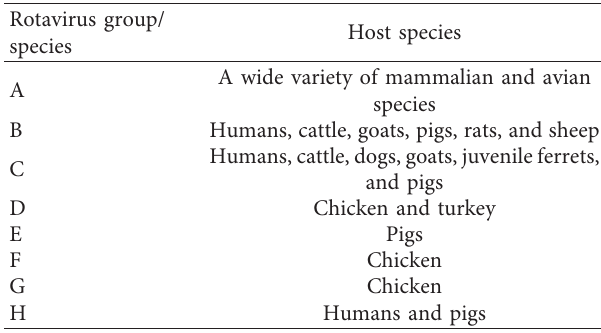
Table 2: Rotavirus group detected so far in different mammalian and/or avian host species.